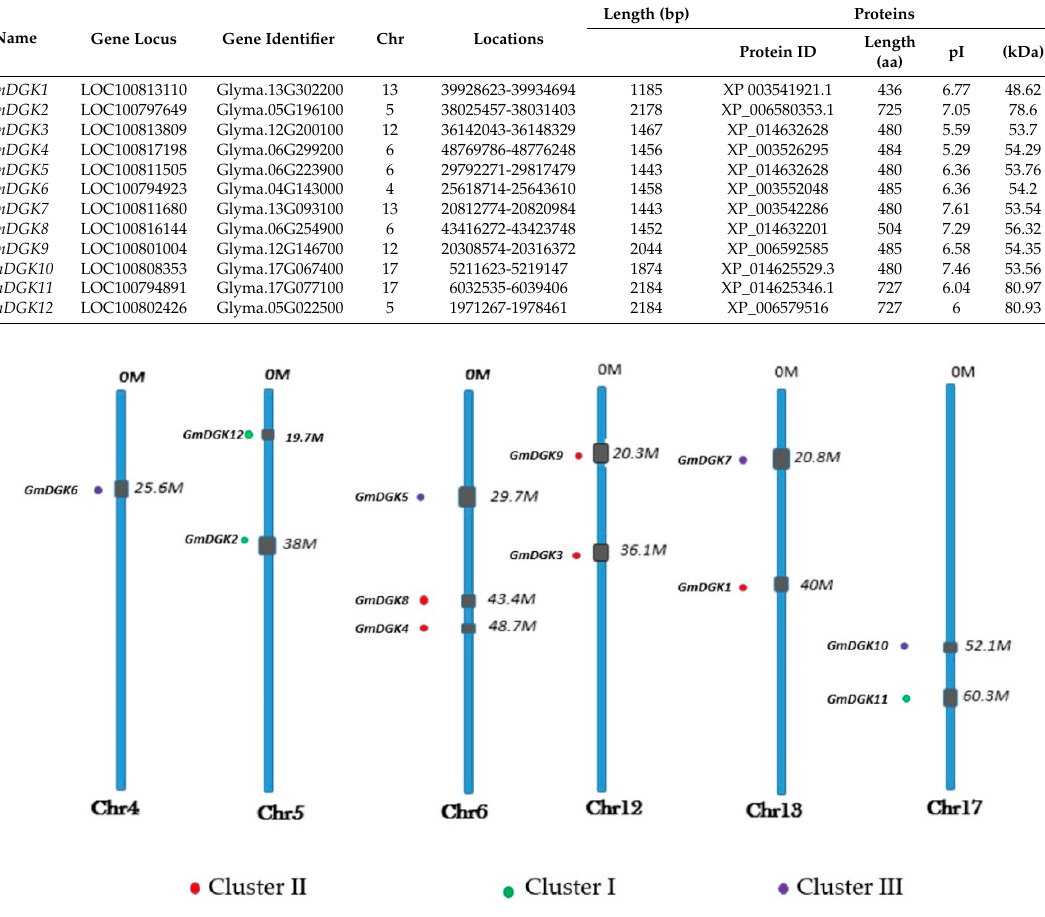
Figure 1. The stance of diacylglycerol kinase ( DGK ) genes family members on soybean chromosomes. Clusters are designated using separately colored spots.